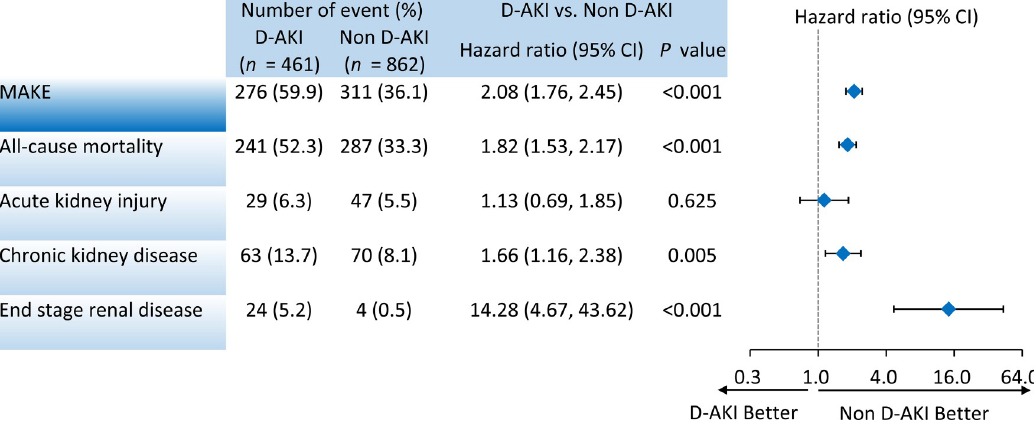
Fig 3. Primary result of major adverse kidney events (MAKE) and each MAKE